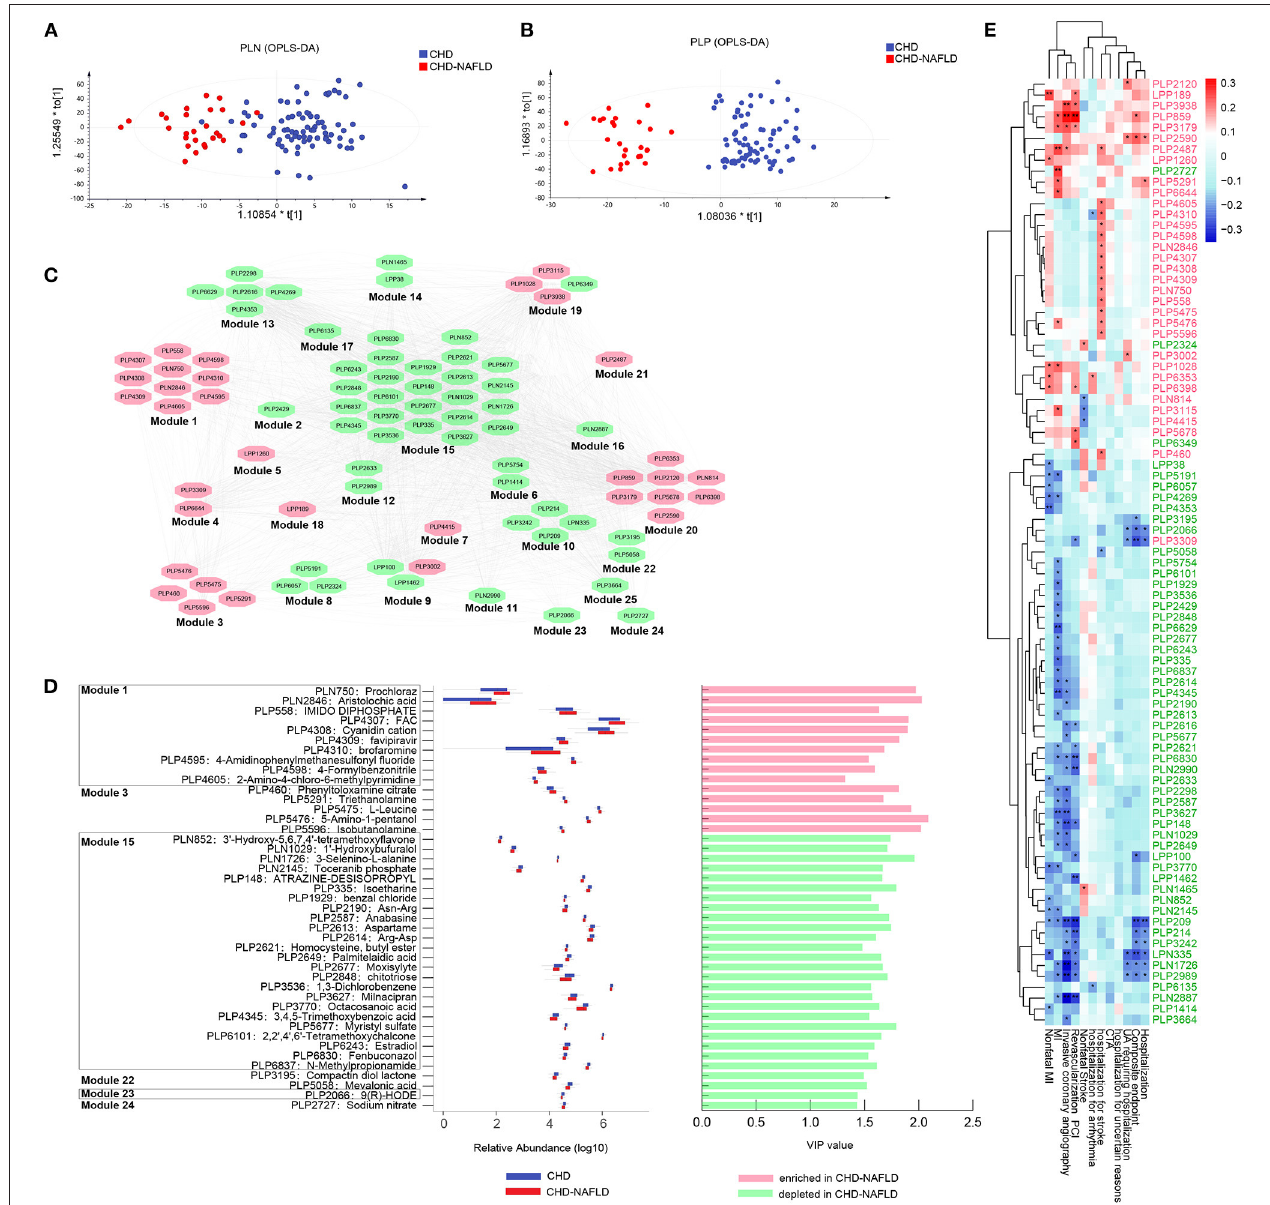
FIGURE 1 | Serum metabolites were significantly changed and correlated with poor clinical outcomes in CHD-NAFLD patients. (A,B) Separation of serum metabolome between patients with CHD-NAFLD and patients with CHD under polar ionic negative mode and polar ionic positive mode, revealed by orthogonal partial least squares discrimination analysis (OPLS-DA). (C) Distinct serum metabolites cluster analysis by Pearson correlation. Red ovals represent metabolic modules that contains metabolites that are enriched in CHD-NAFLDs. Green ovals are metabolic modules that contains metabolites depleted in CHD-NAFLD. (D) Relative abundance and variable importance in projection (VIP) value of several distinct serum metabolites annotated by Human Metabolites Data Base (HMDB). Blue box: relative abundance in CHD group. Red box: relative abundance in CHD-NAFLD group. The bars on the right show enrichment (highlighted in pink) or depletion (highlighted in green) of specific serum metabolites in CHD-NAFLD group when compared with CHD group. The VIP values are also presented. (E) Spearman analysis of the covariant relationship between key metabolome and adverse cardiovascular events. Pink font: serum metabolites enriched in CHD-NAFLD. Green font: serum metabolites depleted in CHD-NAFLD. * P < 0.05, ** P <